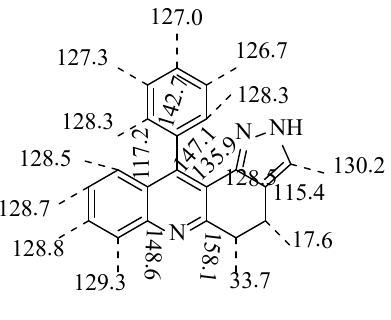
Figure 4: Summary of Carbon d Values 4a.